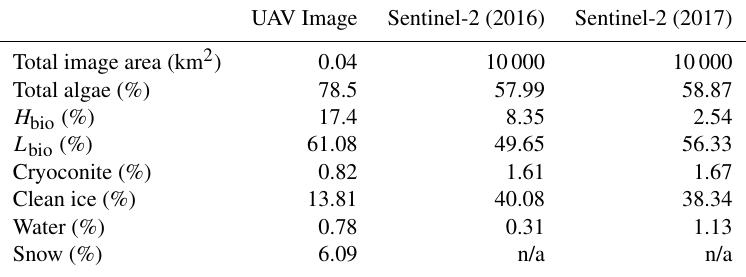
Table 4. Percentage of each image covered by each surface type as predicted by our trained RF algorithm. Snow was removed from the calculation in the Sentinel-2 images to enable quantification of surface coverage in the bare-ice zone, i.e. below the snow line,